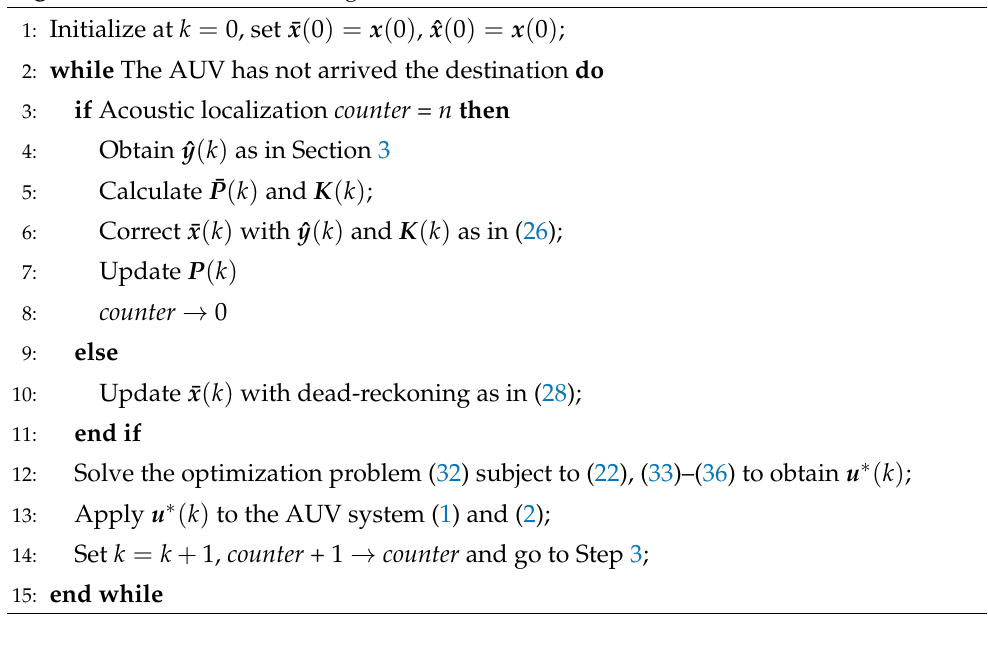
Algorithm 1 Predictive tracking control of AUV with acoustic localization and